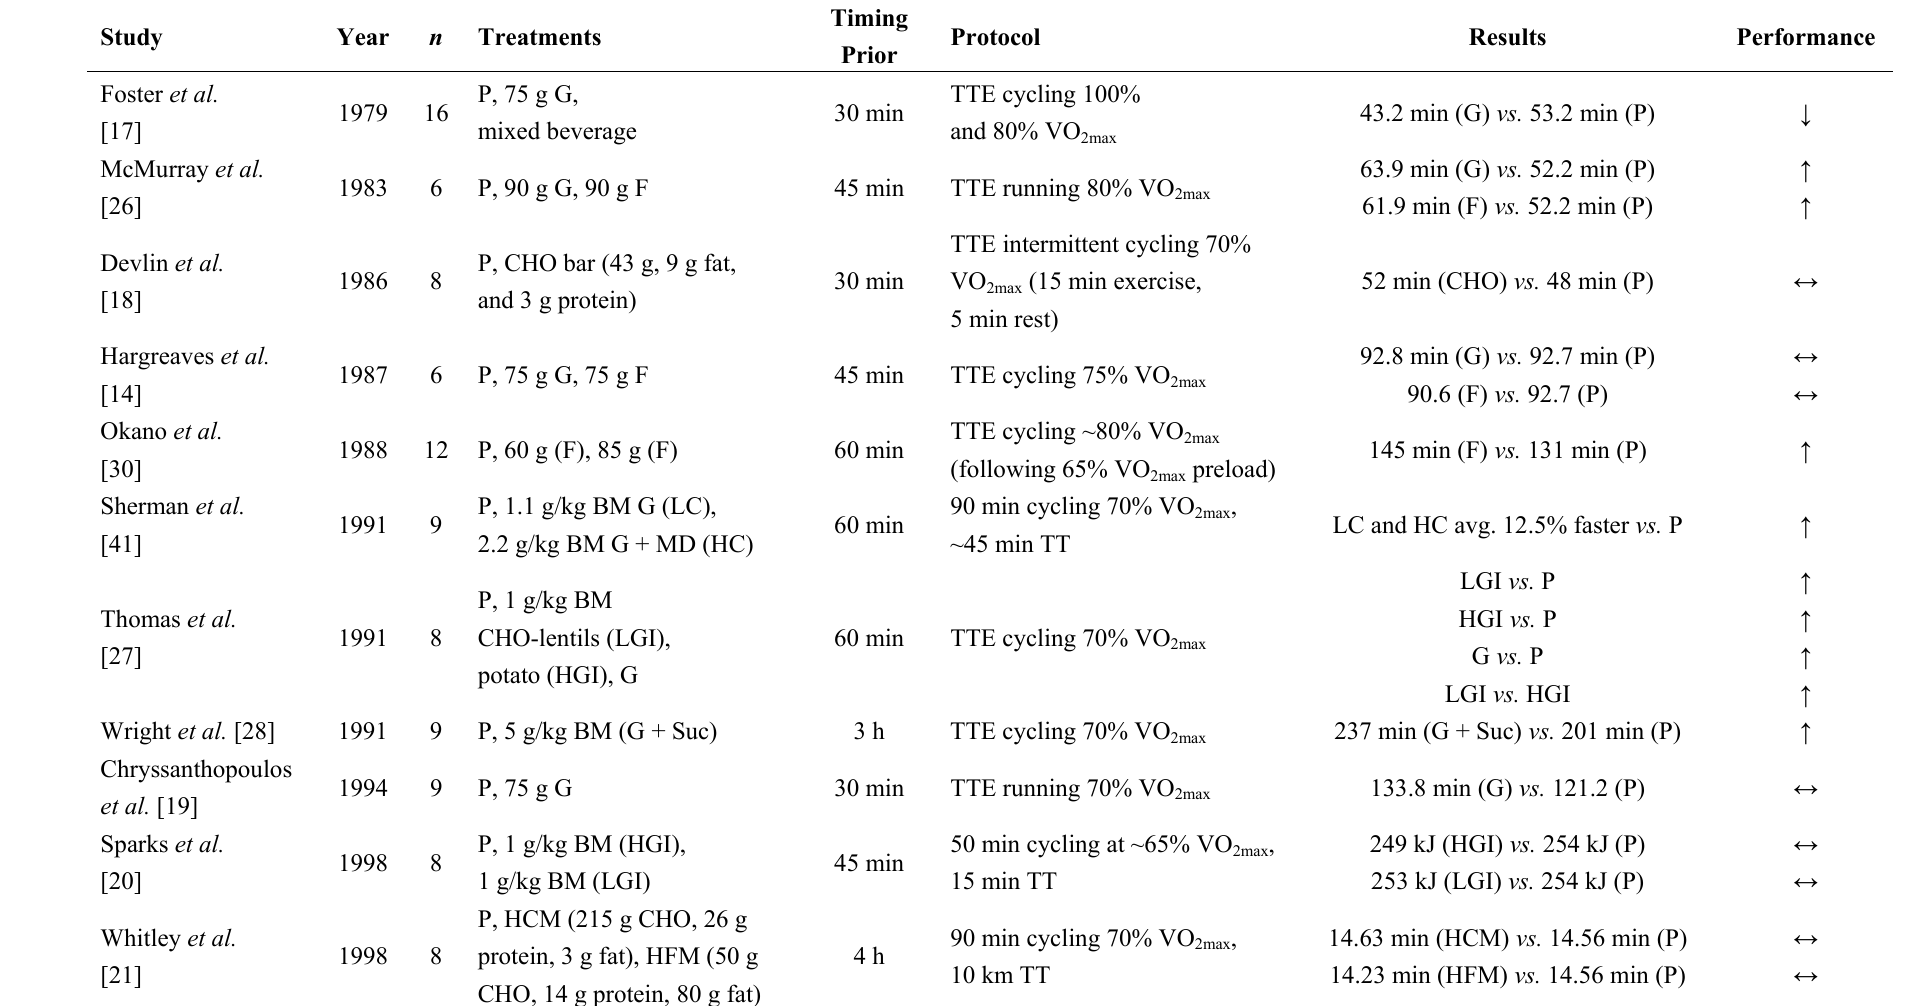
Table 1. The effect of pre-exercise carbohydrate feedings on performance or exercise